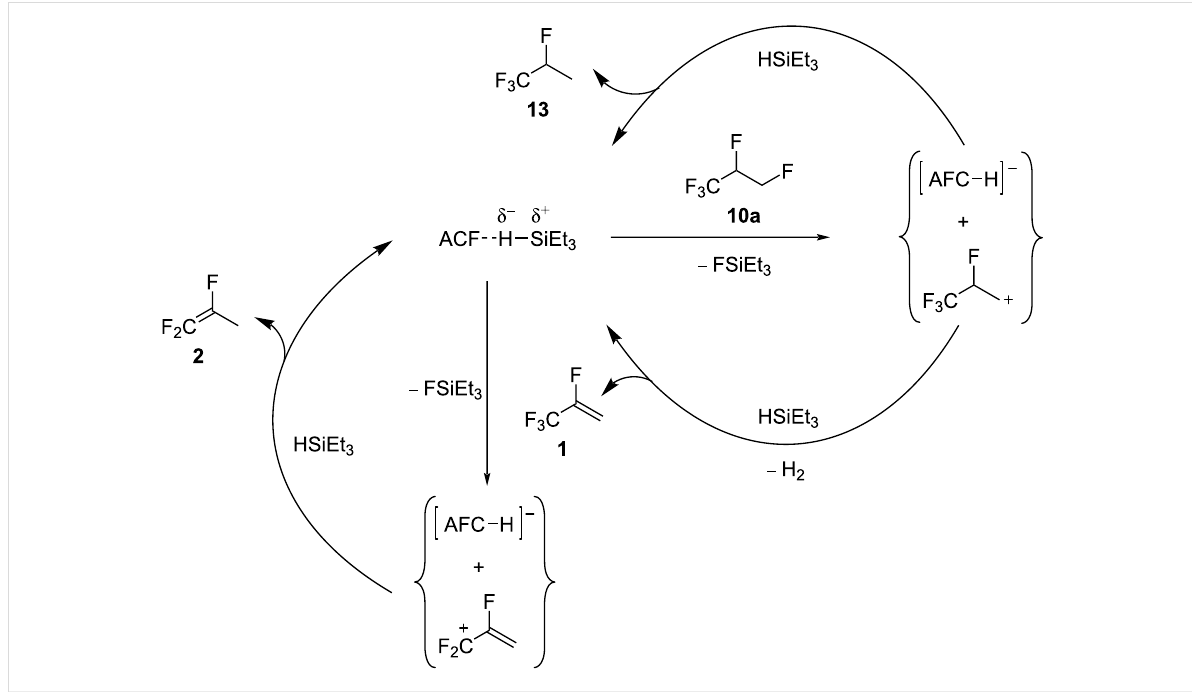
Scheme 5: Proposed catalytic cycle for sylilium-mediated hydrodefluorinations and dehydrofluorinations from 10a at the surface of ACF.